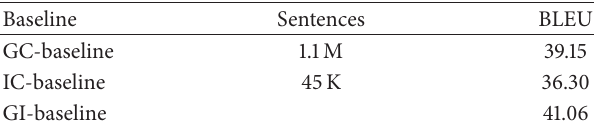
Table 3: BLEU via general-domain and in-domain corpus.